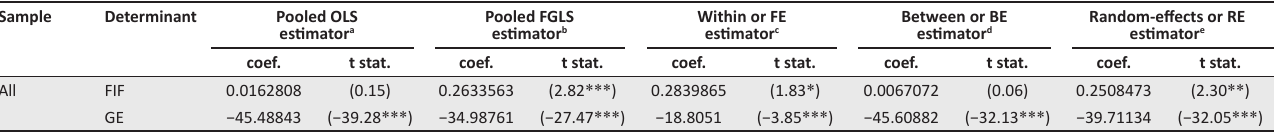
TABLE 11: Variation of corruption depends on fiscal freedom variable and government effectiveness, by level of development: All. Sample Determinant Pooled OLS